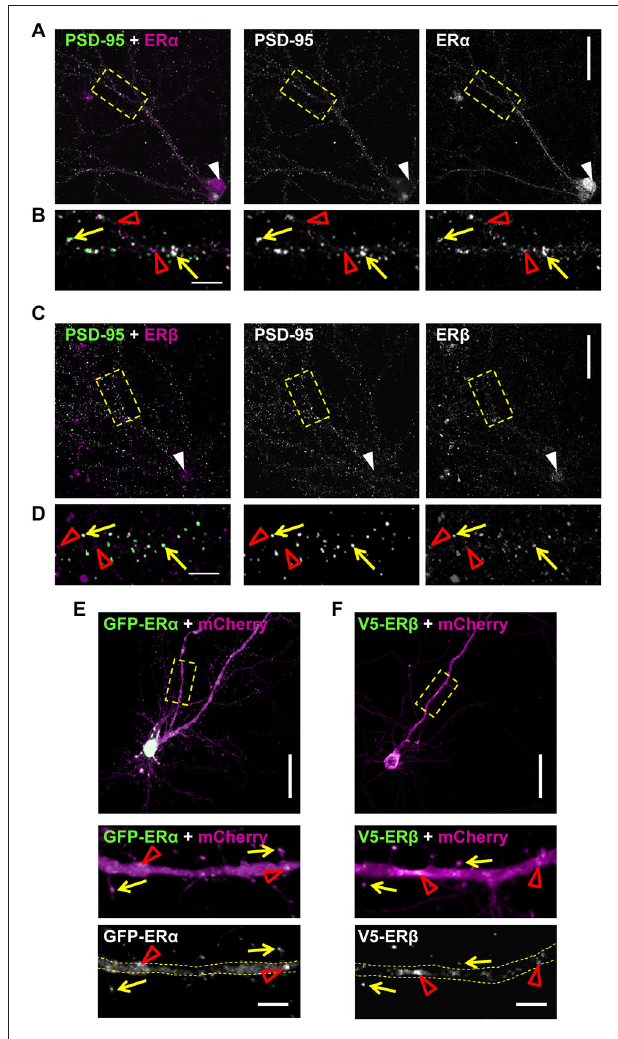
FIGURE 4 | Extranuclear localization of classic estrogen receptors (ERs) in primary cortical neurons. (A) Representative confocal images of primary cortical neurons (DIV 23) co-stained for endogenous ER α and PSD-95. Low magnification images demonstrates nuclear staining for ER α (white arrow heads) in addition to presence along dendrites. Yellow dashed boxes indicate magnified dendritic regions shown in (B) . (B) High magnification images reveal that a subset of ER α puncta co-localizes with PSD-95 (yellow arrows); the remaining puncta are likely present in dendrites (open red arrow heads). (C) Co-staining of endogenous ER β and PSD-95 reveals the presence of the receptor in the nucleus (white arrow head) and along dendrites in DIV 23 primary cortical neurons. (D) Examination of distal dendrites as denoted by yellow dashed box in (C) reveals that ER β is present at both extra-synaptic synaptic regions, as demonstrated by co-localization (yellow arrows) or lack thereof (open red arrow heads) with PSD-95. (E,F) Representative confocal images of DIV 25 primary cortical neurons ectopically co-expressing GFP-ER α or V5-ER β with mCherry (to outline neuronal morphology). Yellow dashed boxes denote regions of dendrites magnified in insets. Ectopic ERs localize along dendrites (open red arrow heads) and to dendritic spines (yellow arrows). Scale bar = 50 µ m (A,C,E,F) ; 5 µ m ( B,D,E inset and F inset).